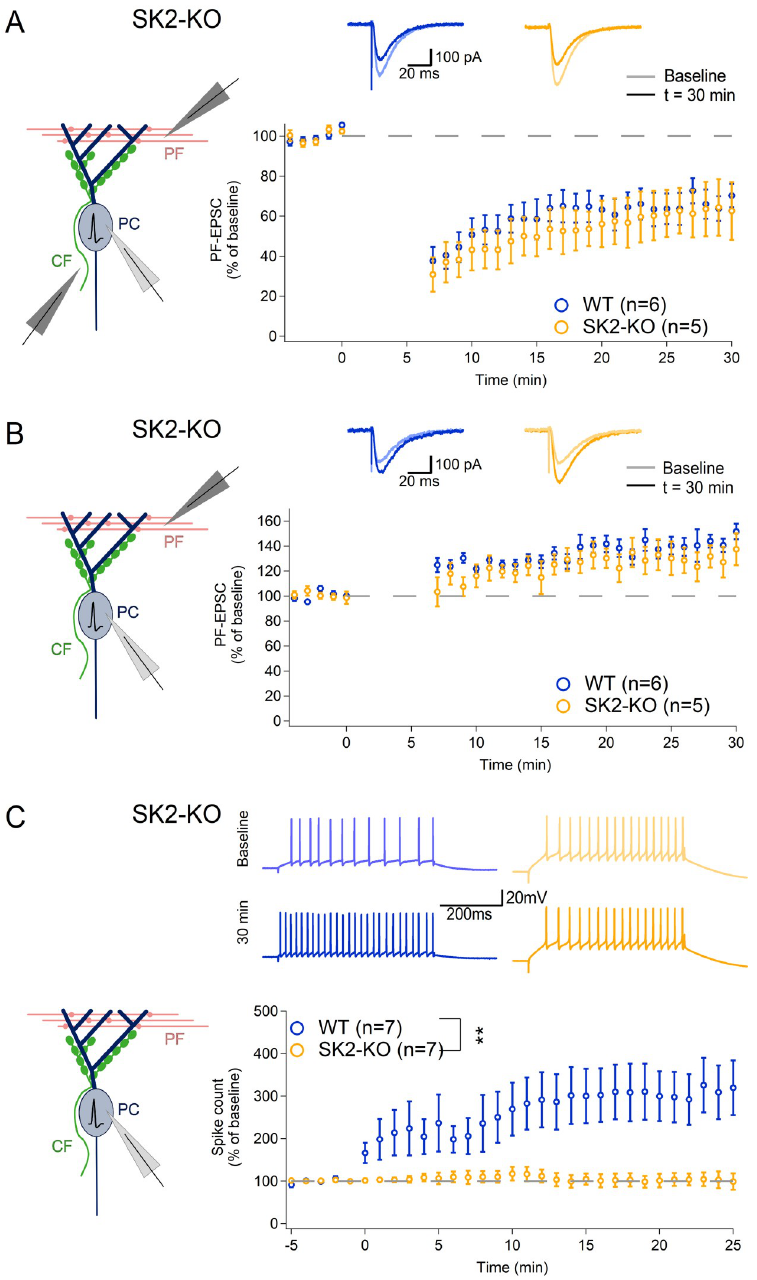
Fig 3. Intrinsic plasticity is selectively impaired in SK2-KO PCs. (A) LTD is induced at comparable levels at PF synapses in SK2-KO PCs and WT littermates (induction protocol: 1-Hz paired PF + CF single pulse, 5 min). Upper panel: representative traces of PF-EPSCs. Lower panel: time graph of PF-EPSCs (averaged per minute) before and after the induction (at 0 min). (B) LTP is induced at comparable levels at PF synapses in SK2-KO PCs and WT littermates (induction protocol: 1-Hz PF single pulse, 5 min). Upper panel: representative traces of PF-EPSCs. Lower panel: time graph of PF-EPSCs as in A. (C) Intrinsic plasticity cannot be induced in SK2-KO PCs by a somatic depolarization protocol (this panel is reproduced in a modified form from [44]). Upper panel: representative traces of spikes evoked by a somatic depolarizing current injection of fixed amplitude, before (upper) and after (lower) the induction protocol. Lower panel: time graph of spike count (averaged per minute) before and after the induction (at 0 min). �� p < 0.01. CF, climbing fiber; EPSC, excitatory postsynaptic current; KO, knockout; LTD, long-term synaptic depression; PC, Purkinje cell; PF, parallel fiber; WT, wild